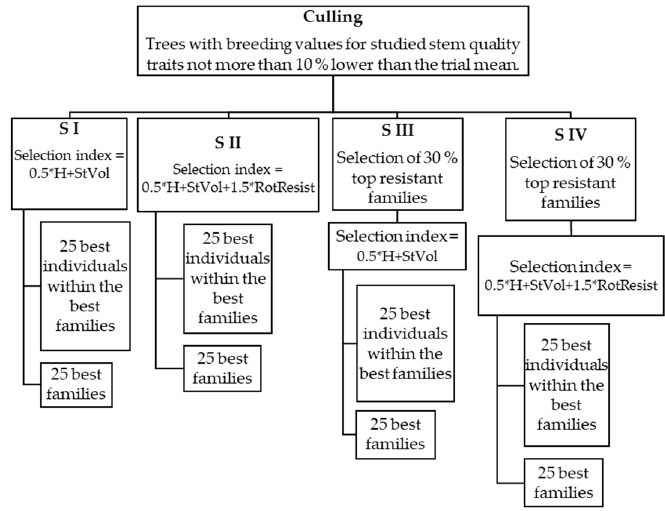
Figure 1. Scheme of the different selection criteria applied. Abbreviations: H—tree height; StVol—stem volume; RotResist —root rot resistance index.